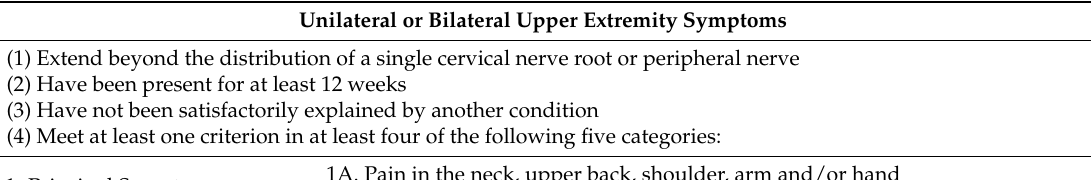
Table 1. Preliminary criteria for the clinical diagnosis of Neurogenic Thoracic Outlet Syndrome